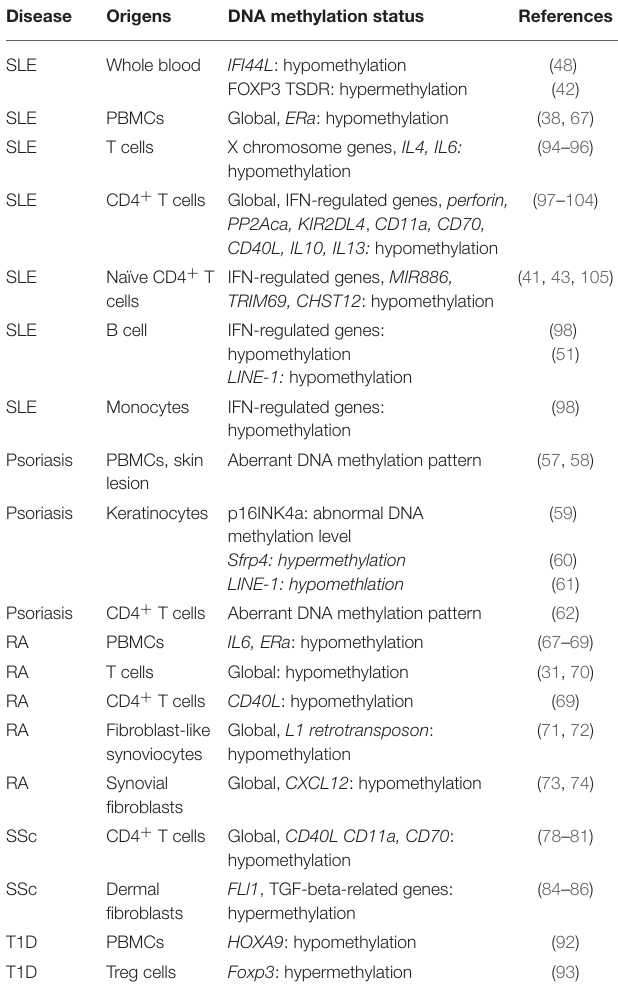
TABLE 1 | Dysregulated DNA methylation in autoimmune diseases: SLE, Psoriasis, RA, SSc, and T1D. Disease